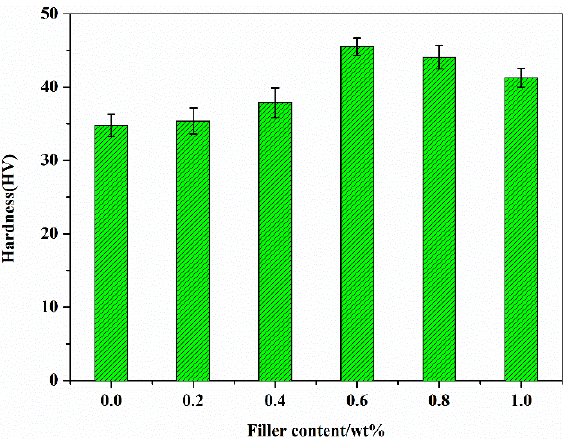
Figure 8. The hardness of the G/COFs/BMI composites containing different filler contents.